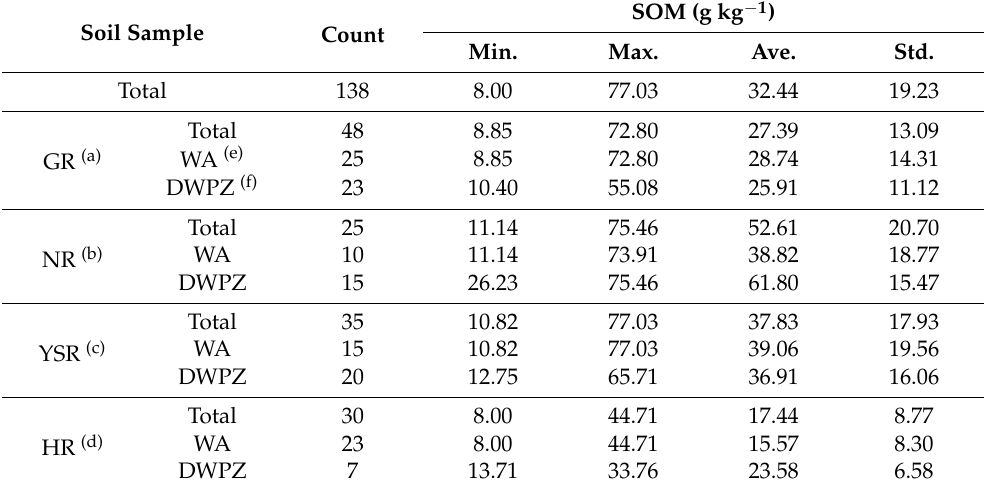
Table 2. Soil organic matter (SOM) contents of topsoil samples from the basins of the four major rivers in the Republic of Korea. SOM (g kg − 1 ) Soil Sample Count Min. Max. Ave.